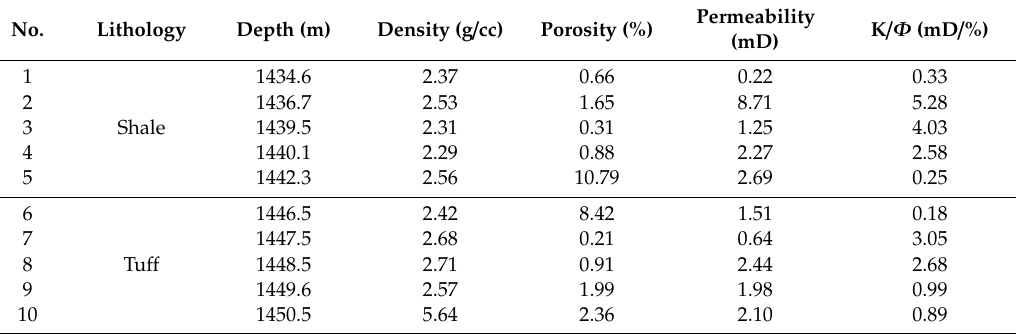
Table 2. Porosity and permeability.